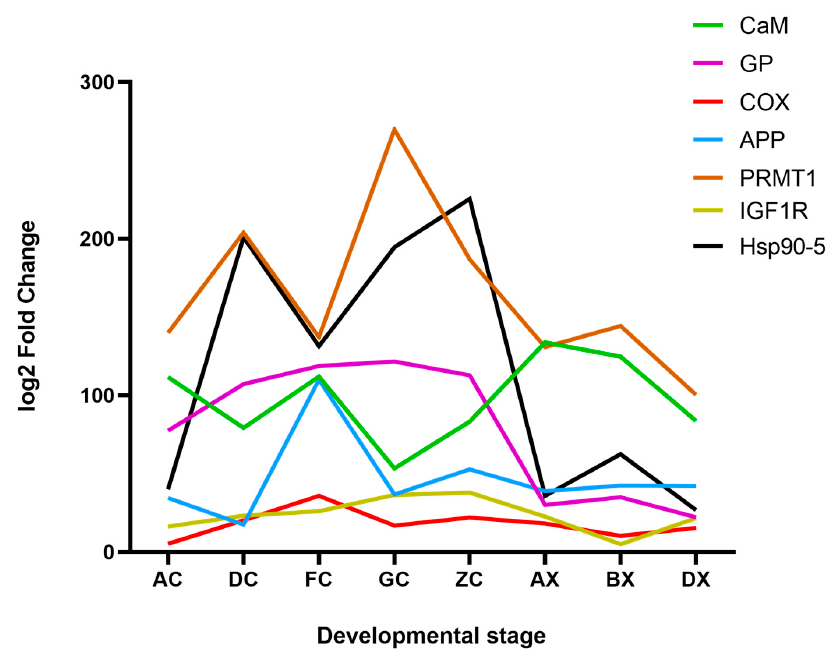
Figure 8. Expression level of several common differentially expressed genes in KEGG